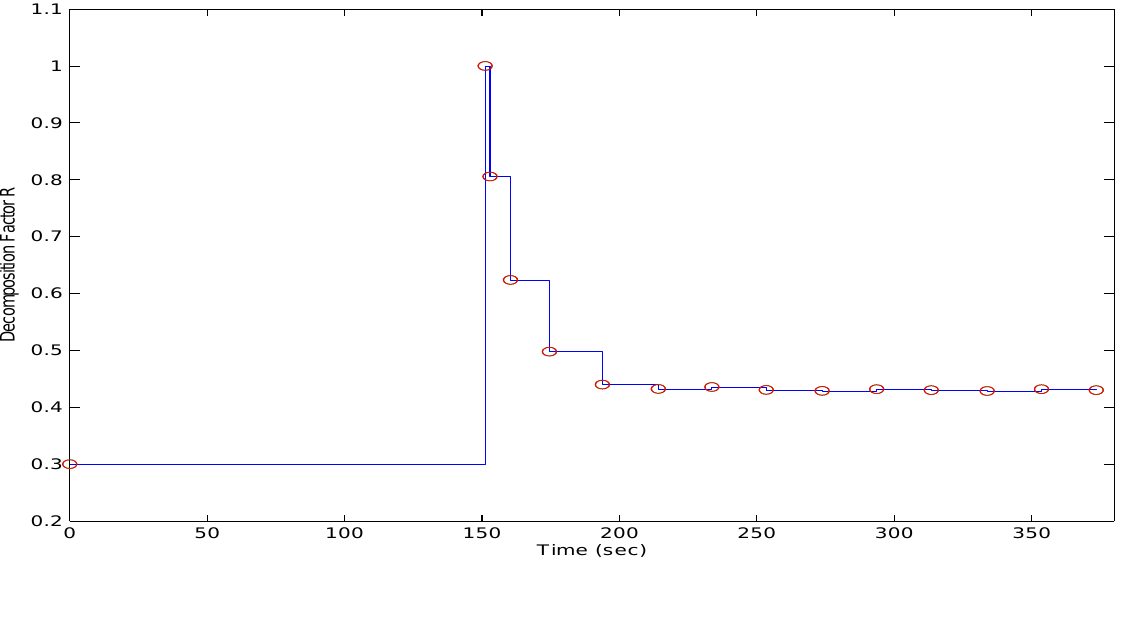
Figure 17 . Convergence Error over experimental time (Initial values R = 0 : 9 , T d = 10 s, and (cid:22) = 0 : 01